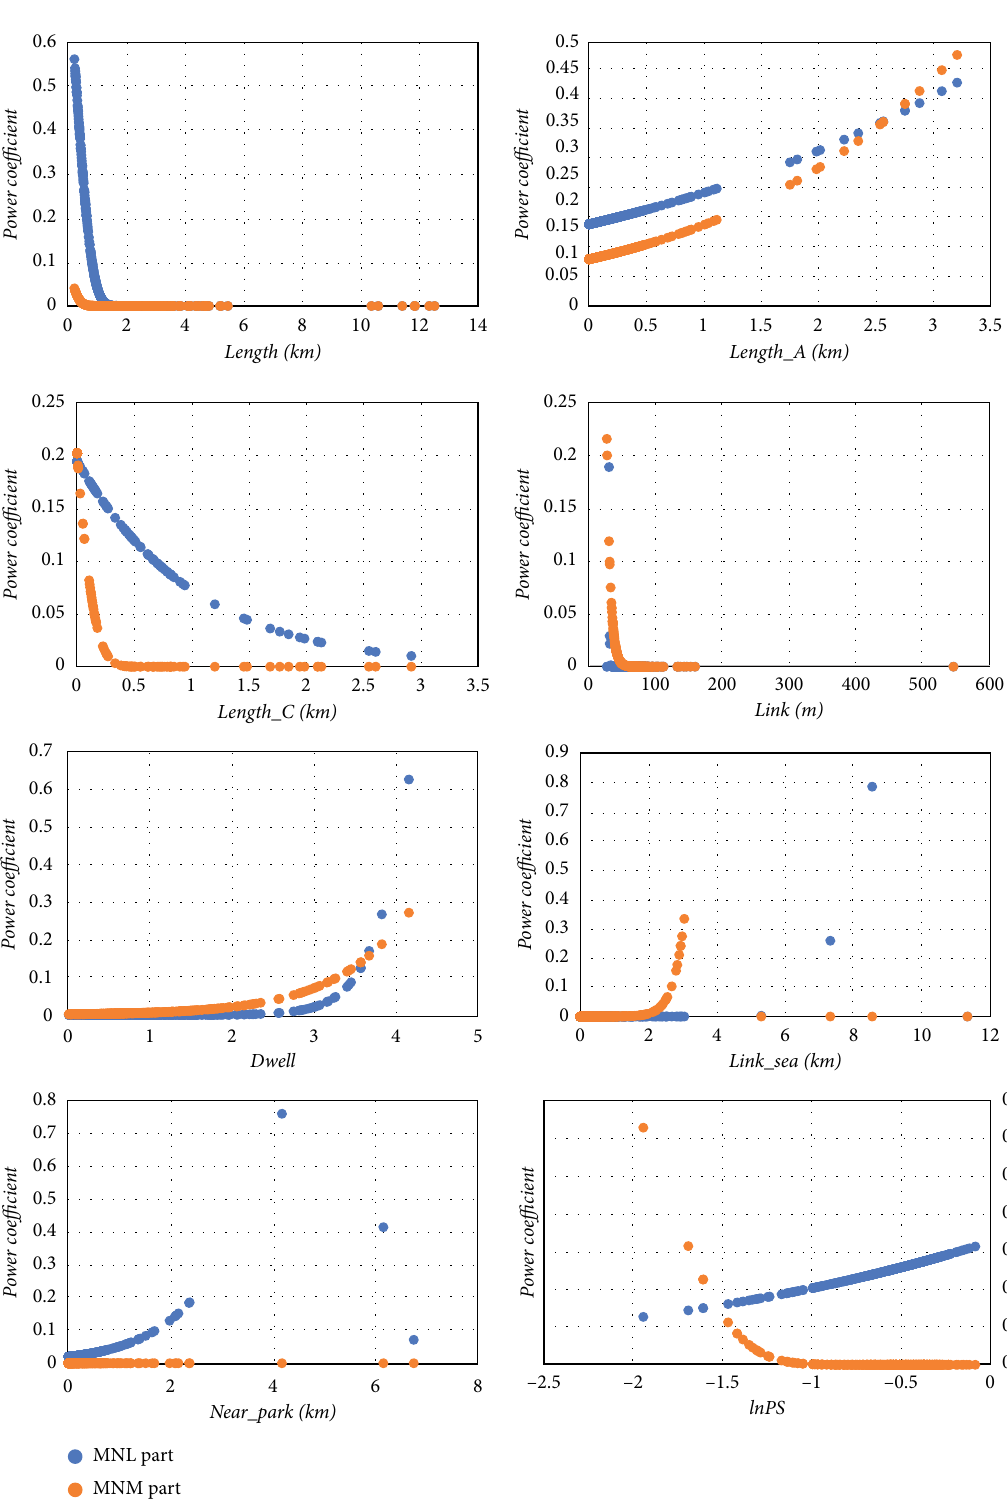
Figure 14: Scatter plots of individual power coe ffi cients of di ff erent